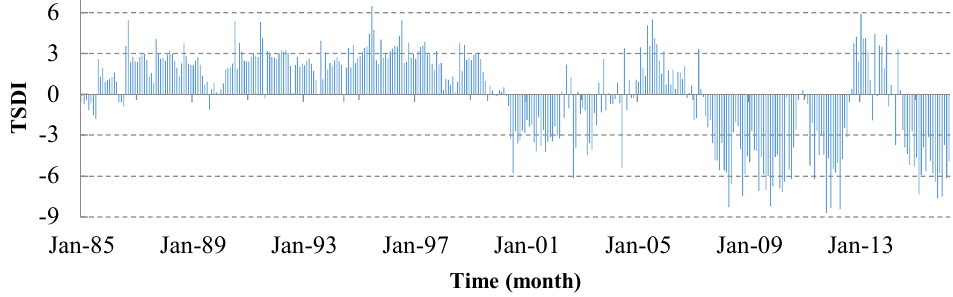
Figure 12. Monthly TSDI of the Liao River Basin.